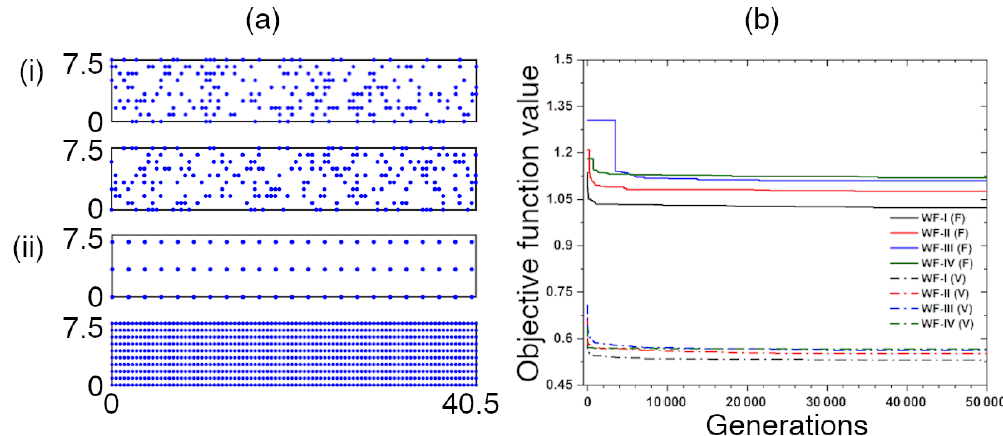
Figure 3. (a) Initial parents for the (i) OPTIMAL_F and (ii) OPTIMAL_V layouts for WF-I. (b) Evolution of the value of the objective function.